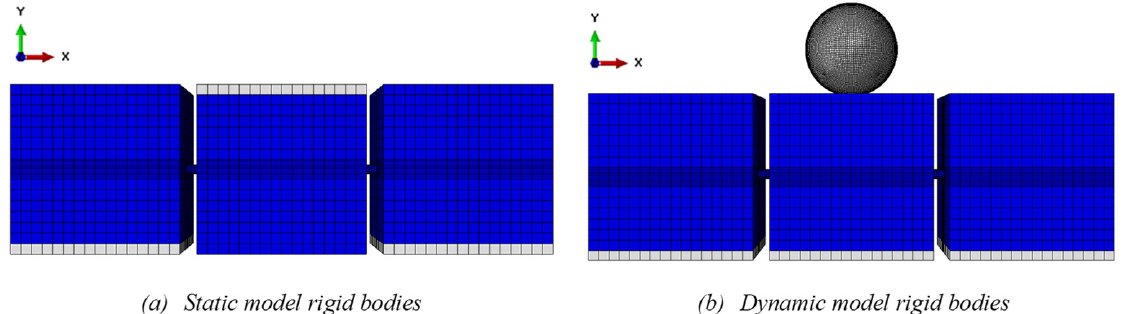
Figure 7. Assigned rigid bodies (indicated in white).